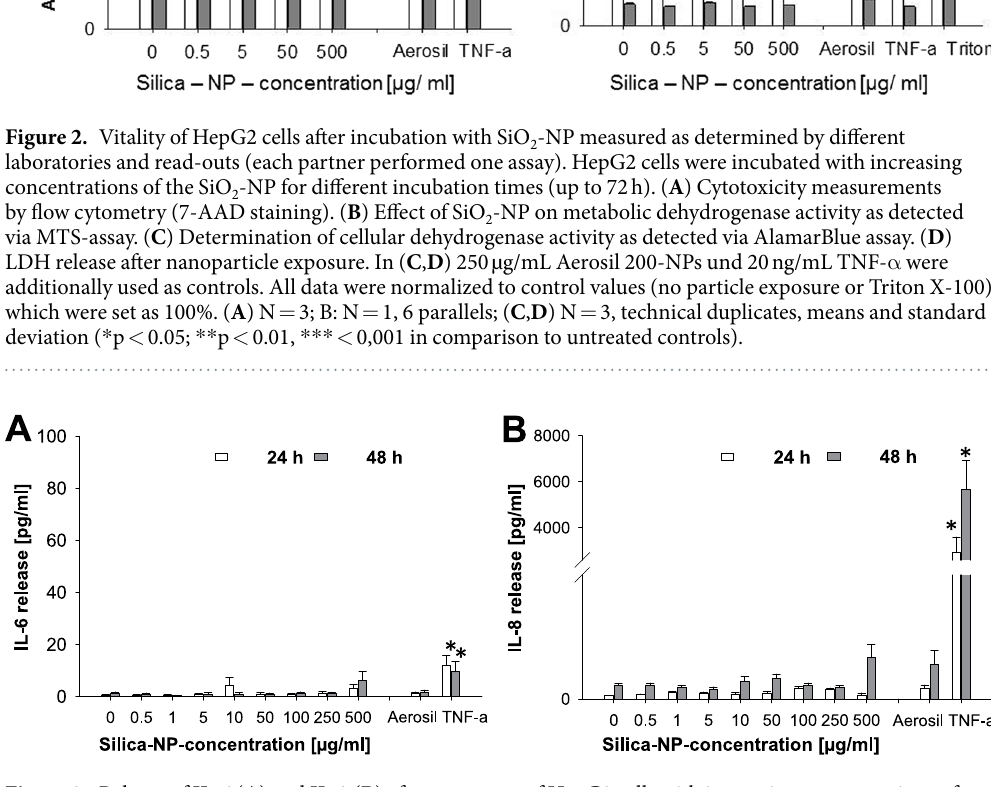
Figure 3. Release of IL-6 ( A ) and IL-8 ( B ) after treatment of HepG2 cells with increasing concentrations of SiO 2 -NPs after 24 and 48 h. 250 μ g/mL Aerosil 200 NPs und 20 ng/mL TNF- α were used as positive controls. N = 3, technical duplicates, means and standard deviation ( * p < 0.05; ** p < 0.01 in comparison to untreated